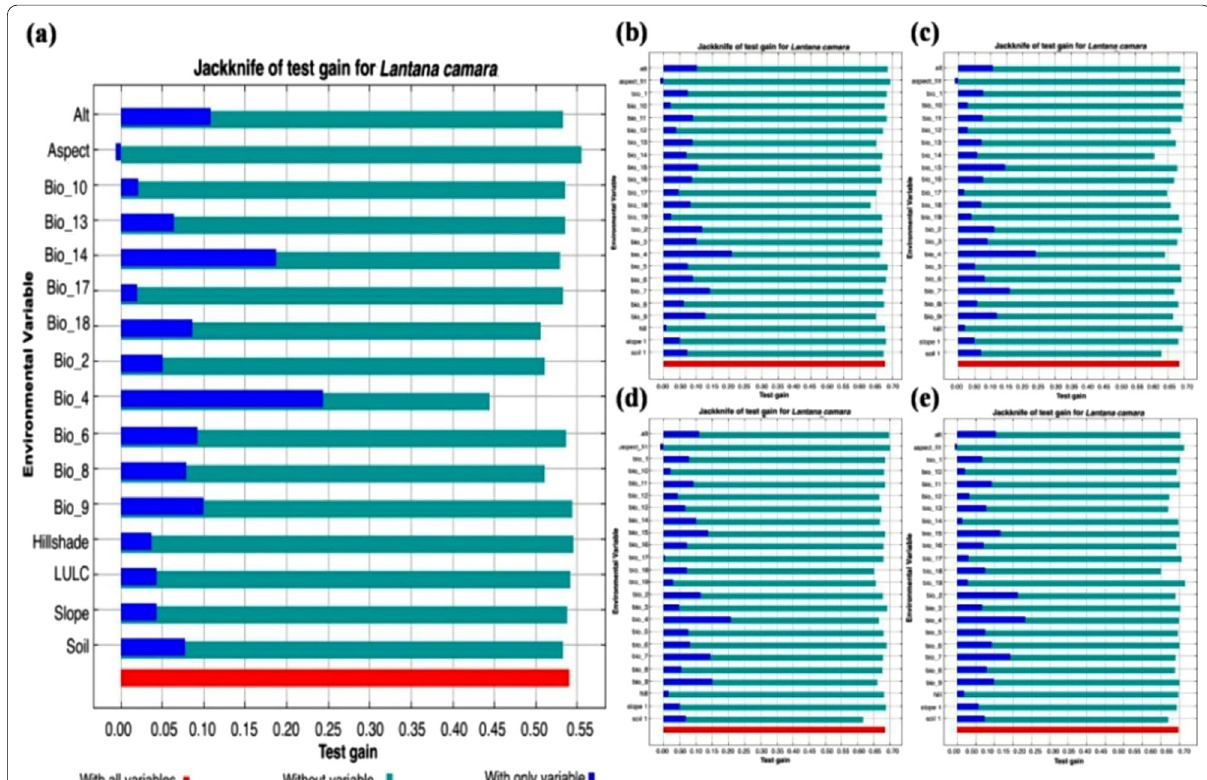
Fig. 4 Jackknife test gain result on area under curve (AUC) value for evaluation of predictor variable significance for ( a ) 2020, and ( b – e ) 2050 for